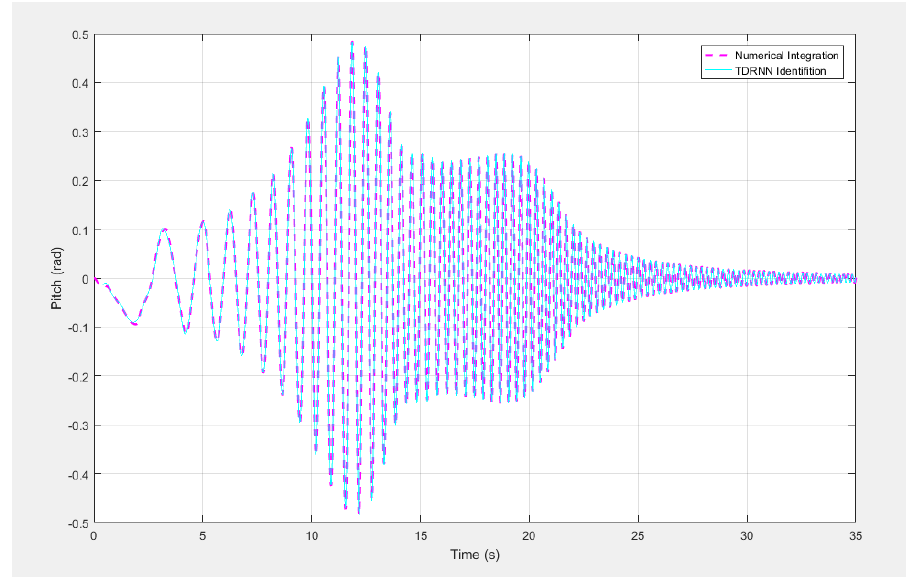
Figure 8. Response of chirp input signal.